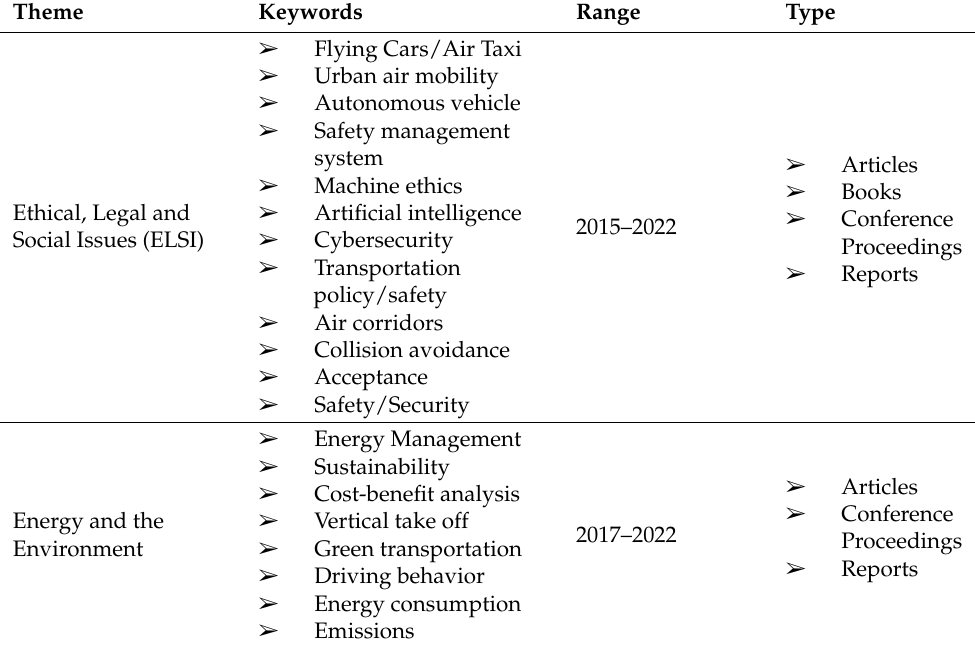
Table 1. Literature Review Source